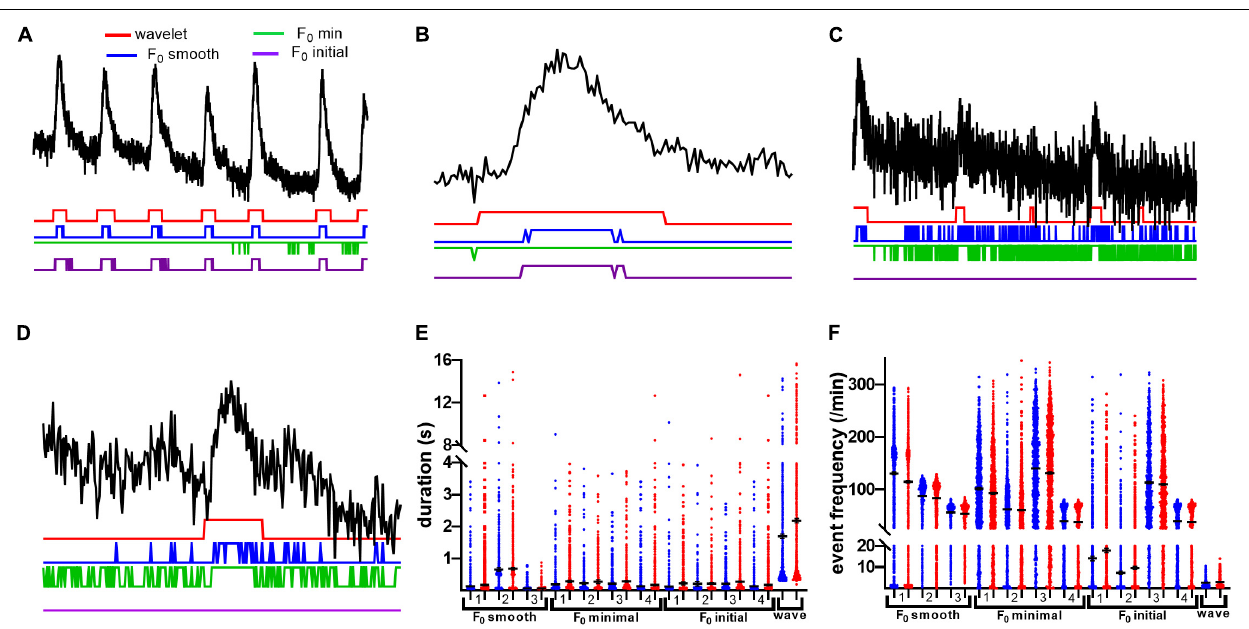
FIGURE 7 | df/F 0 thresholding methods fragment events with effects on Ca 2 + activity measures. (A) A 1-min sample of neuronal trace, with example rasters beneath. All F 0 methods were thresholded at 2.5 times the standard deviation of the baseline. Note that, where wavelet finds continuous events, F 0 methods have a tendency to introduce fragments. Furthermore, in the case of F 0 minimal, most of this trace is deemed active, with little to no segregation between events. (B) A zoomed short segment of a neuronal trace with high SNR. Notice that even in high SNR conditions, fragmentation still occurs. (C) A 1-min sample of a low SNR neuronal trace with example rasters beneath. All F 0 methods were thresholded as in (A) . With low SNR, there is increased fragmentation by F 0 smooth and F 0 minimal methods. F 0 initial thresholding fails utterly for this trace. (D) A zoomed short segment of a neuronal trace with low SNR. F 0 initial fails to identify this event. (E) Distributions of mean event durations for presumed neurons from saline and cocaine self-administration groups as calculated by the various methods. The number for each method indicates thresholding criteria as follows: 1, baseline sd*2.5; 2, trace sd*2.5; 3, z -score baseline p = 0.05; 4, trace z -score p = 0.05. Note that the wavelet method finds events to be of longer duration due to lack of fragmentation effects. (F) Neuronal event frequency distributions. All F 0 thresholding methods identify several times more events than the wavelet ridgewalking method for the same